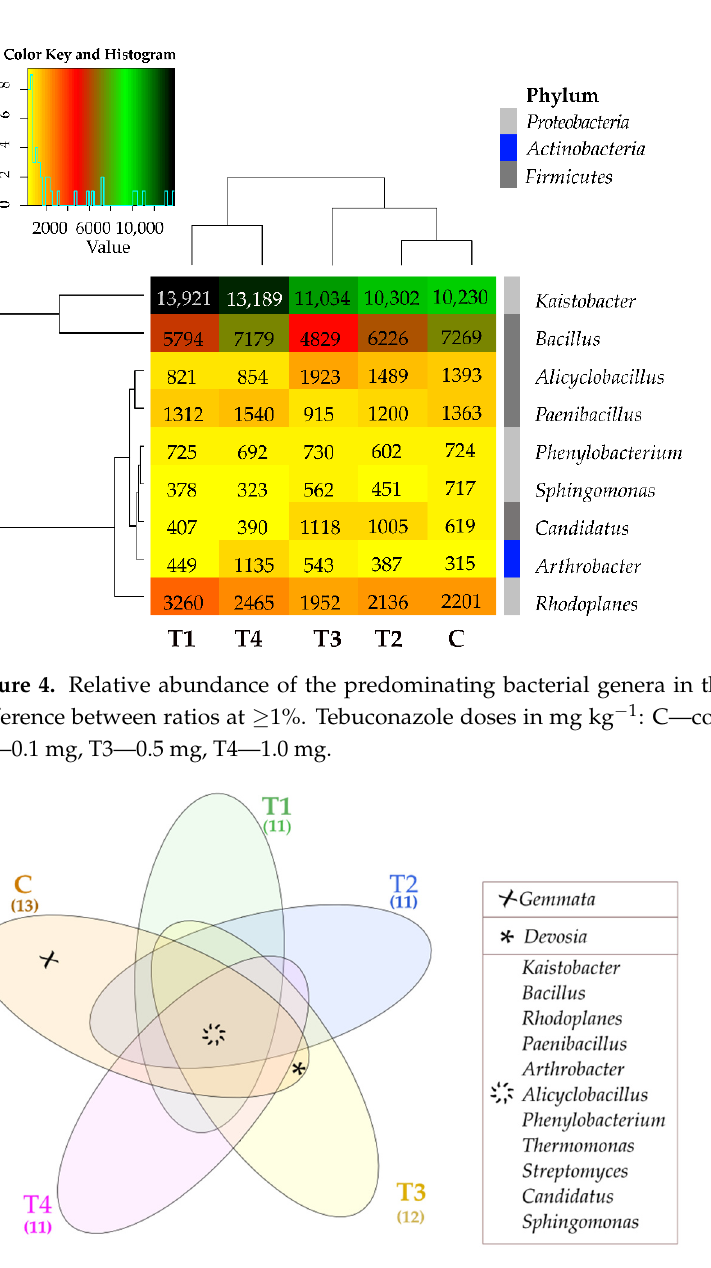
Figure 5. Venne’s diagram depicting unique and common bacterial genera, OTU ≥ 1%. Tebuconazole doses in mg kg − 1 : C—control soil, T1—0.01 mg, T2—0.1 mg, T3—0.5 mg, T4—1.0 mg.